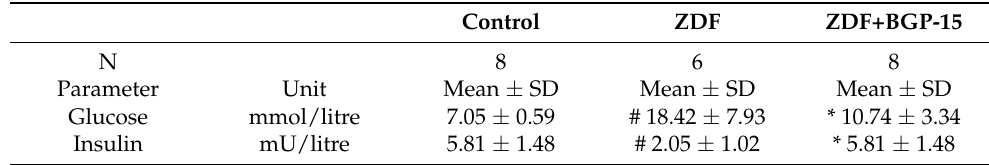
Table 3. Glucose metabolism related